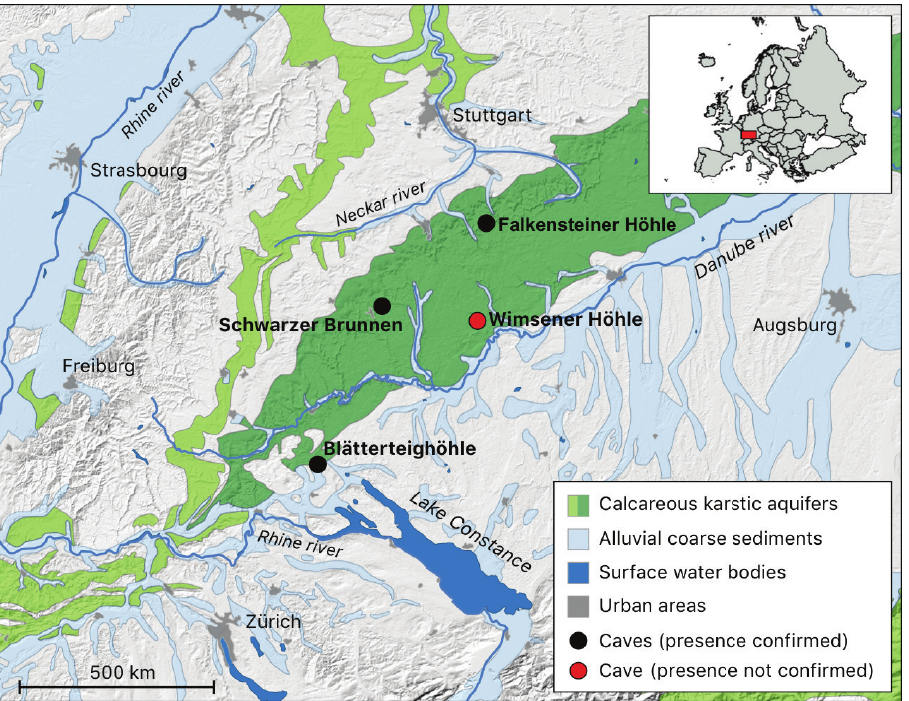
Figure 2. Distribution of Niphargus enslini . Black circles indicate the type locality and the new sampling sites; Wimsener Höhle where Niphargus virei is cited is reported in red. All the sites are clearly located in the same karstic aquifer. The record from Buchbrunnenquelle is not indicated here as it is probably